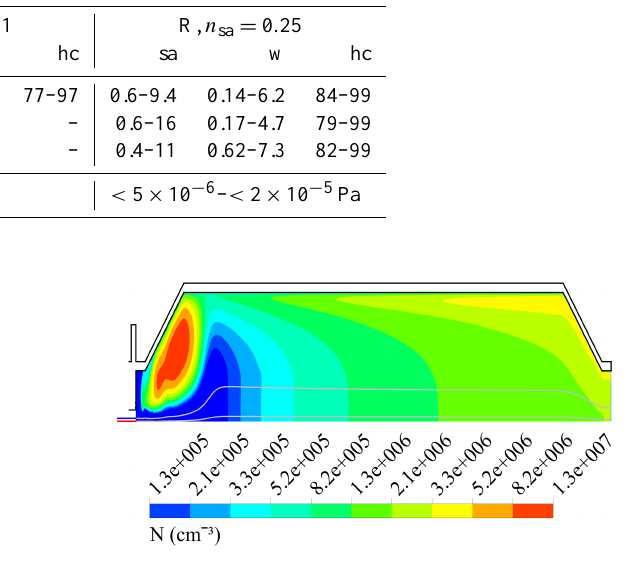
Figure 13. Particle concentration in the aging chamber region when there is [ H 2 SO 4 ] = 4 . 6 × 10 10 cm − 3 in raw exhaust of A case with n sa = 1 and when turbulent diffusion for particles is neglected. The path lines are also shown. The figure is scaled vertically with a fac- tor of